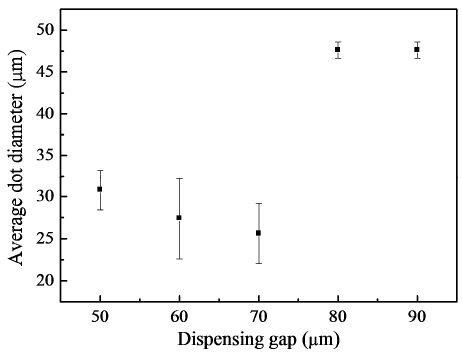
Figure 8. Average dot diameter versus dispensing gap for aqueous glycerol mixture (80 vol% glycerol).